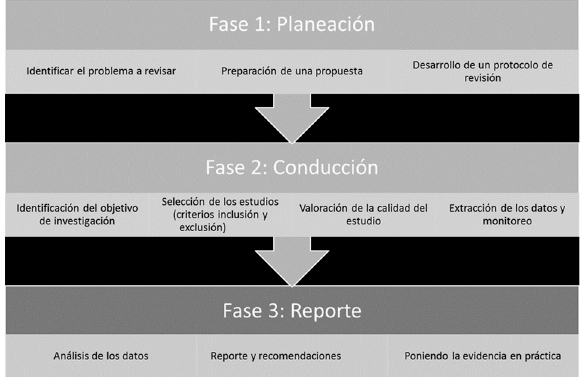
Figure 1. Phases of systematic literature mapping (modified with information from Tranfield, Denyer & Smart,